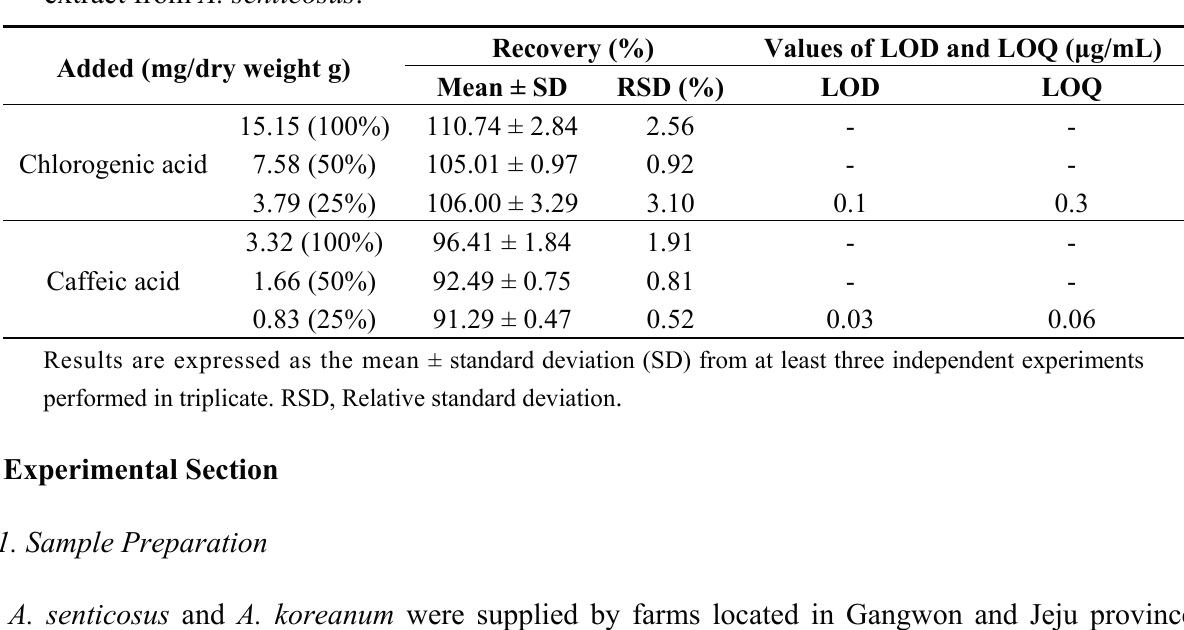
Table 5. The recovery, LOD and LOQ values of chlorogenic acid and caffeic acid in the leaf extract from A. senticosus